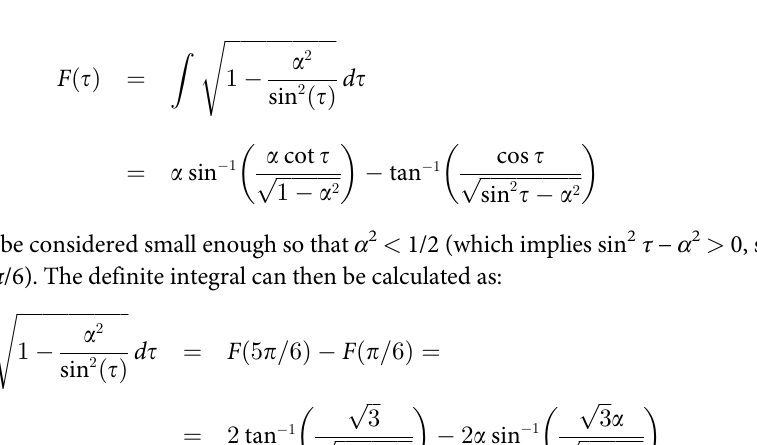
ffiffiffiffiffiffiffiffiffiffiffiffiffiffiffi p 1 (cid:0) 4 a 2 3 r 1 ffiffiffiffiffiffiffiffiffiffiffiffiffiffiffiffiffi